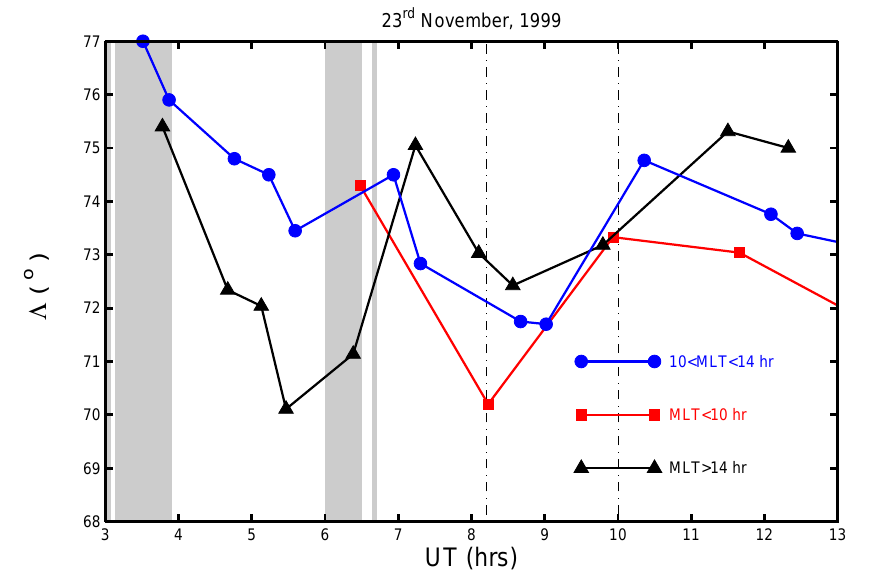
Fig. 10. Invariant latitudes 3 of DMSP satellite crossings of the open-closed boundary in the 10 < MLT ≤ 14h sector (blue circles), at MLT ≤ 10h (red squares); and MLT > 14h (black triangles). As in Fig. 3, the areas shaded grey are northward IMF and the vertical dot- dashed lines mark the expansion/recovery phases of the larger